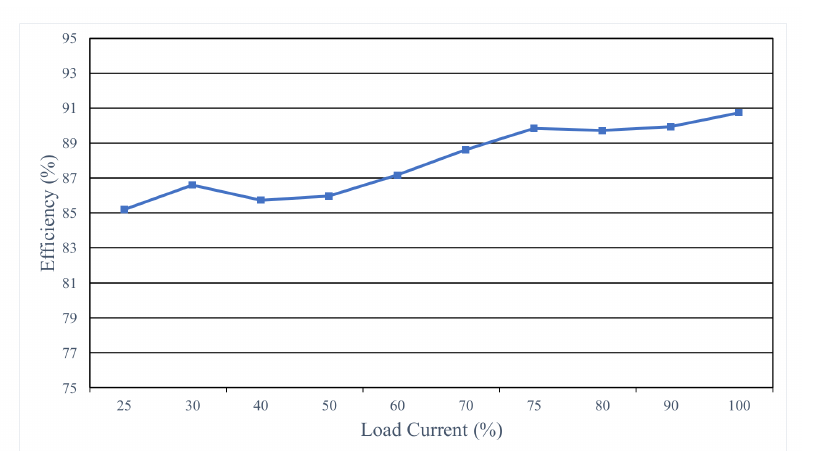
Figure 35. Curve of efficiency versus load